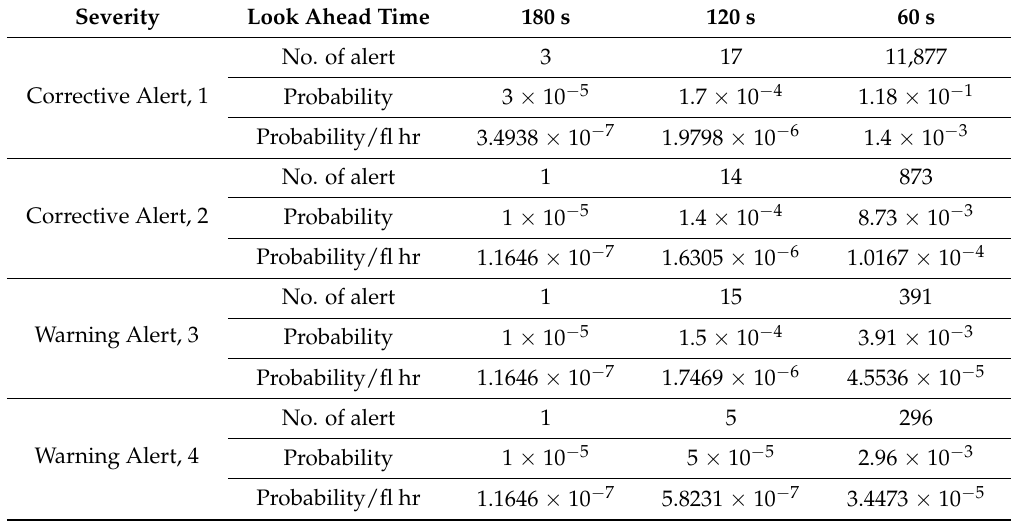
Table 10. Alert probability summary, head-to-head encounter.